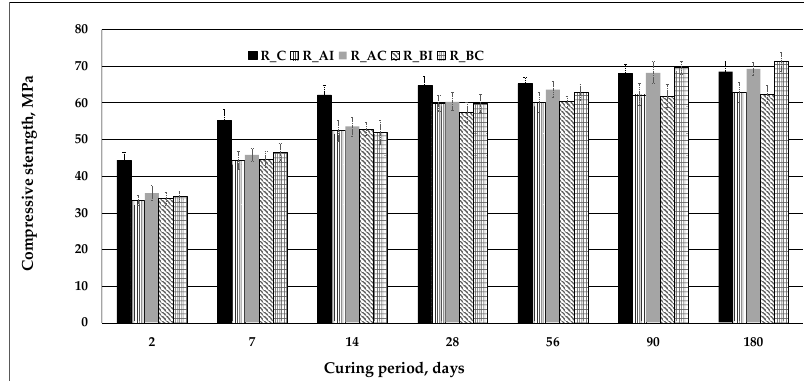
Figure 8. MCS results for CSA-based mortars cured between 2–180 days. At the shortest curing period (2 days), the blended cements exhibit compressive strength values about 22% lower than mortars only containing R_C; this is due to the dilution effect of the GGBFS + activator. Subsequently, as curing time increases, the MCS gap reduces thanks to the continuous hydration of the chemically activated slag. Finally, after 180 days of curing, the blended cements containing Na 2 CO 3 show almost the same MCS values as the reference system; on the contrary, the MCS values for the others mortars are almost 8% lower than those for R_C-based mortar for the same curing period. Figure 9 reports the porosimetric plots for the CSA-based binder pastes cured at 2, 28 and 180 days; they display the cumulative curves for the intruded Hg volume vs. pore radius. The plots show that the total intruded volume reduces with the increase in curing time. For R_C (Figure 9a), the total cumulative volume (TCV) reduced from about 173 mm 3 /g at 2 days of curing to 70 mm 3 /g after 6 months. In the same period, the TCV, respectively, decreases of around 68% (from 243 mm 3 /g to 79 mm 3 /g) and 69% (from 218 mm 3 /g to 67 mm 3 /g) for the R_AI and R_AC systems (Figure 9b,c). As far as the two ternary B-based systems are concerned, the TCV decreases of about 63% (from 213 mm 3 /g to 79 mm 3 /g) for R_BI and 72% (from 195 mm 3 /g to 55 mm 3 /g) for R_BC.